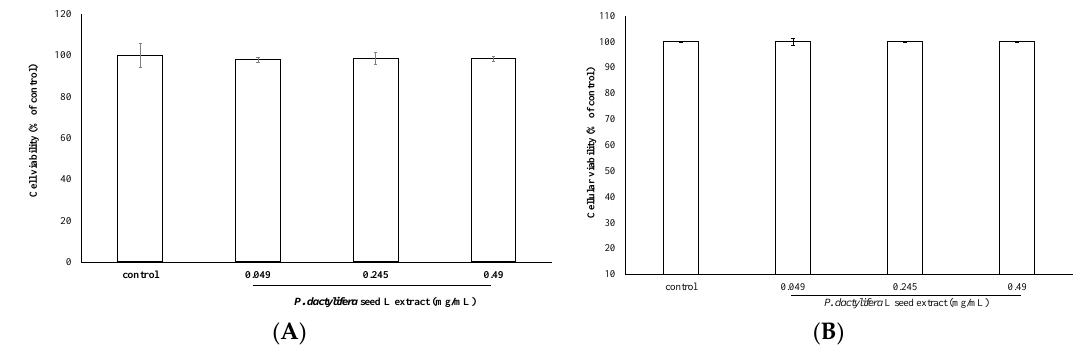
Figure 3. The effect of P. dactylifera L. seed extract on the proliferation of B16F10 cells. Cell viability was measured by the MTT assay method ( A ) and Trypan blue exclusion assay ( B ) after 24 h incubation. Data are expressed as percentages of the number of viable cells observed with the control and each column was presented as mean values ± SD from three independent experiments performed in triplicate.